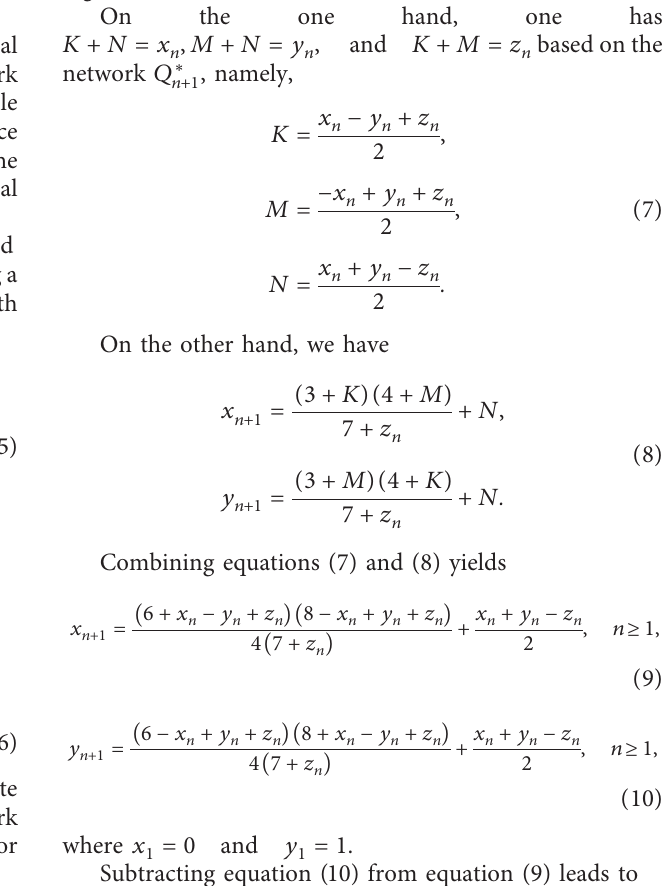
n and linear octagonal network